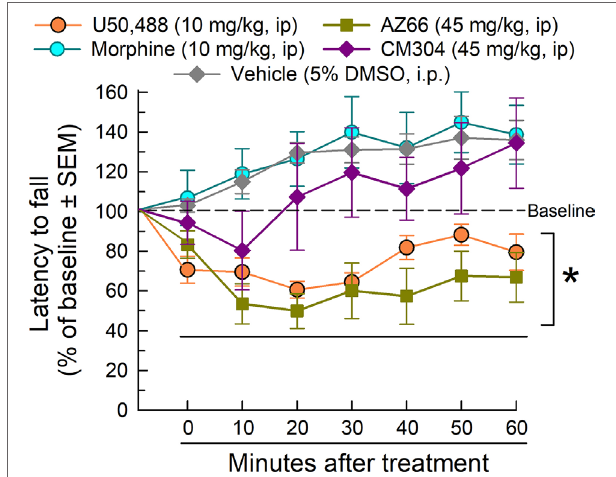
FIGURE 10 | Dose- and time-dependent effects of CM-304 (purple diamonds) or AZ-66 (blue triangles) after a 45 mg/kg i.p. administration in the mouse rotarod assay. U50,488 (orange circles, 10 mg/kg, i.p.) is added as a positive control. * = significantly different than either vehicle effect (gray diamonds), p < 0.05; two-way ANOVA w/Dunnett’s post hoc test; N = 8–12